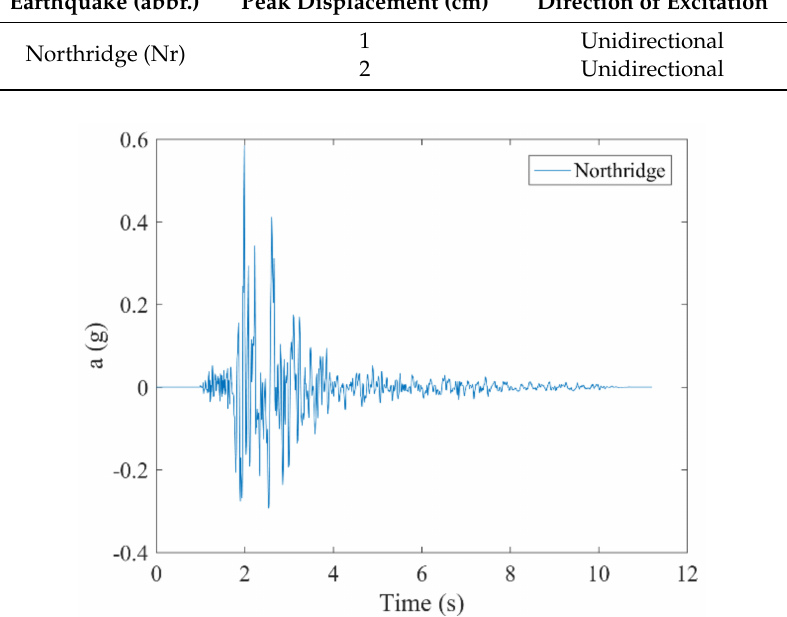
Figure 3. Schematic illustration of an earthquake